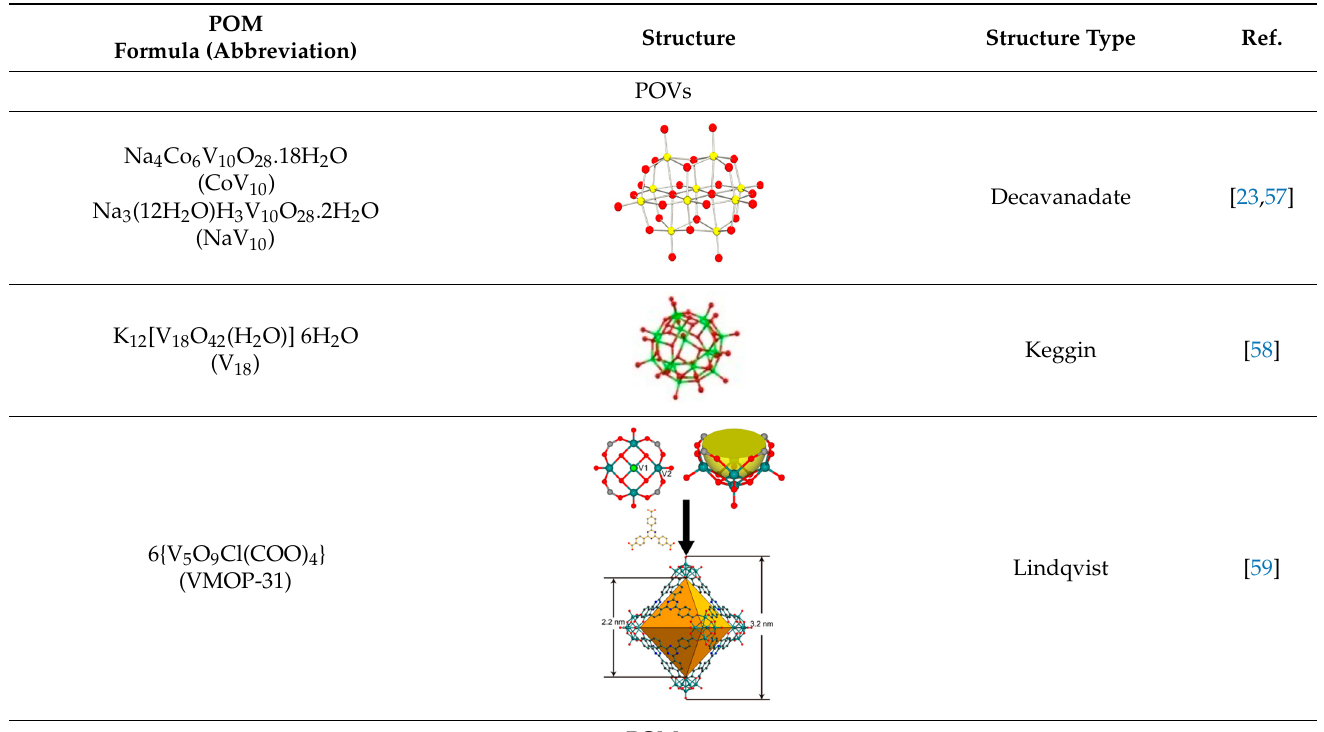
Table 1. Representation of the formula, structure and type of the POMs referred to in the selected articles.